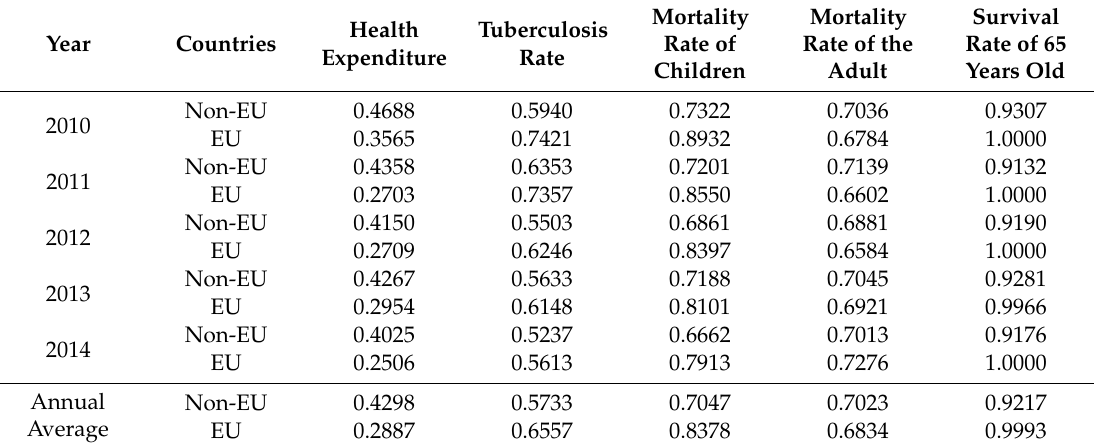
Table 10. Comparison of health e ffi ciencies during 2010 to 2014.